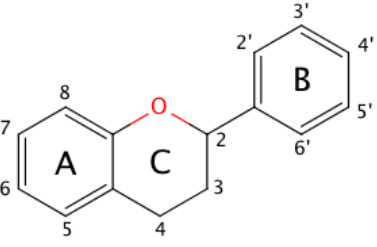
Figure 1. The molecular structure of the flavan nucleus. Substituents present on ring C define families of flavonoids, e.g., a ketone on position 4 yields flavonols, while an oxonium ion in equilibrium with an unsaturated ring gives rise to